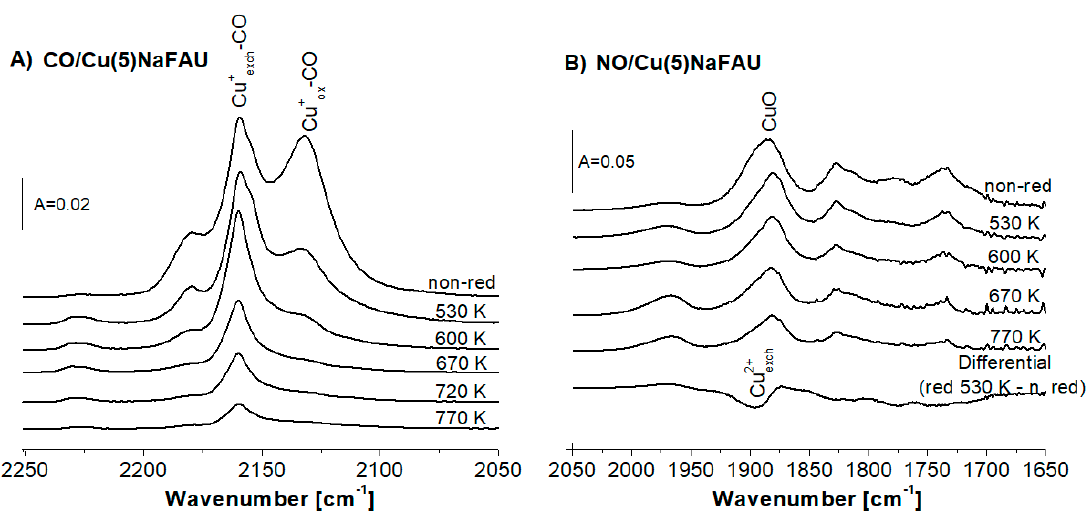
Figure 2. ( A ) The IR spectra of CO sorbed at room temperature on the Cu(5)NaFAU zeolite reduced by hydrogen at various temperatures. ( B ) The IR spectra of NO sorbed at 190 K on the Cu(5)NaFAU zeolite reduced by hydrogen at various temperatures. Bottom spectrum in Figure 3B is the difference between the spectrum of zeolite reduced at 530 K and the nonreduced sample.